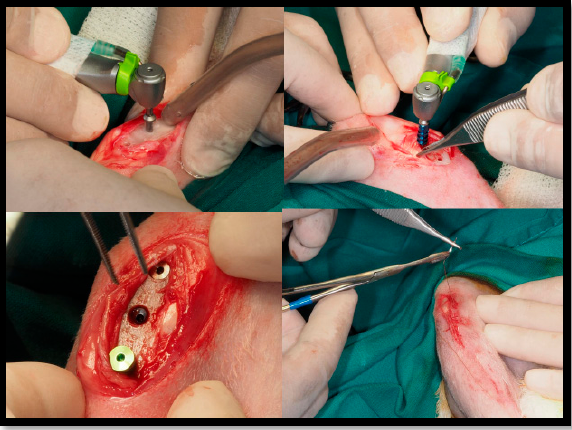
Figure 3. Clinical images of implant placement in animal test rabbits.